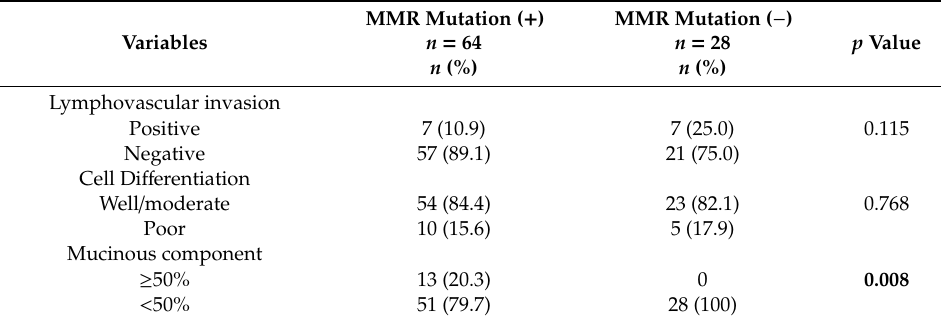
Table 4. The molecular signatures of MSI-high CRC classified by somatic MMR mutations.